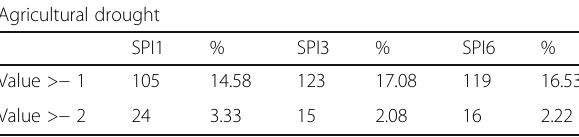
Table 4 Distribution of Agricultural drought events from 1951